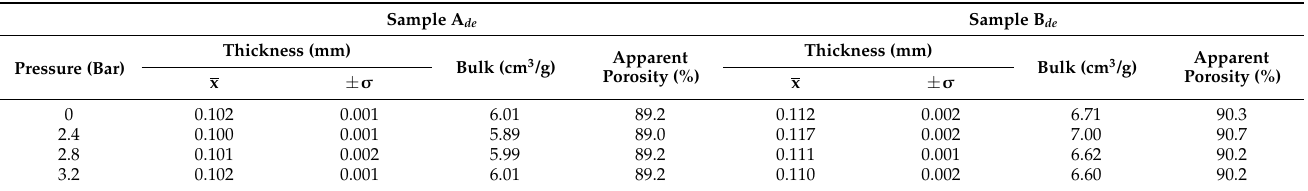
Table 1. Thickness, bulk, and apparent porosity results for the base tissue paper samples A and B at different pressures with deco embossing. Sample A de Sample B de